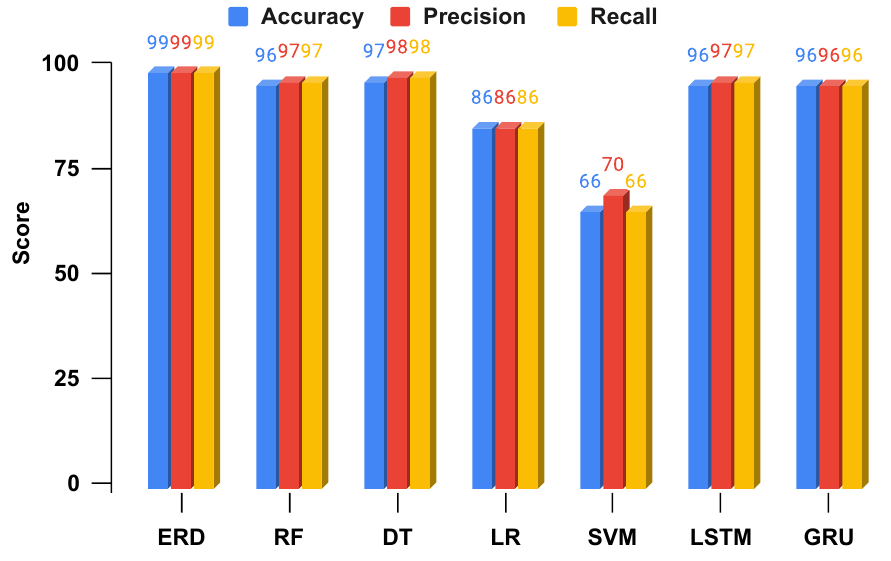
Figure 6. The comparative performance analysis is based on the bar chart of the machine and deep learning models.